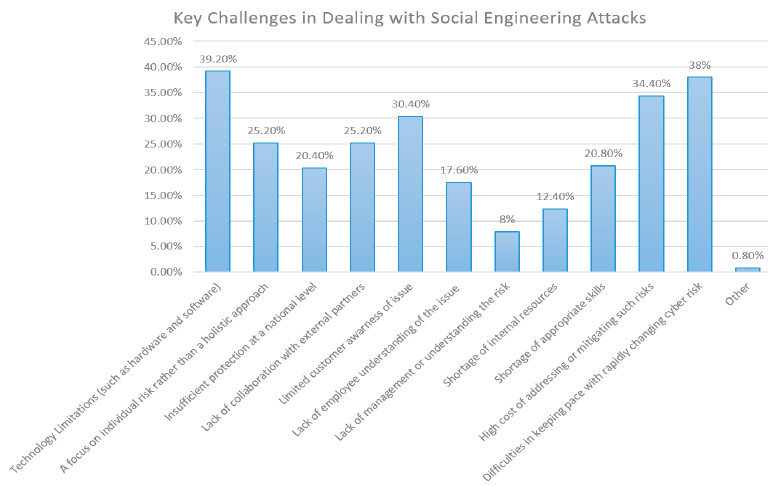
Figure 7. Key challenges in dealing with social engineering attacks (Data from [32]).